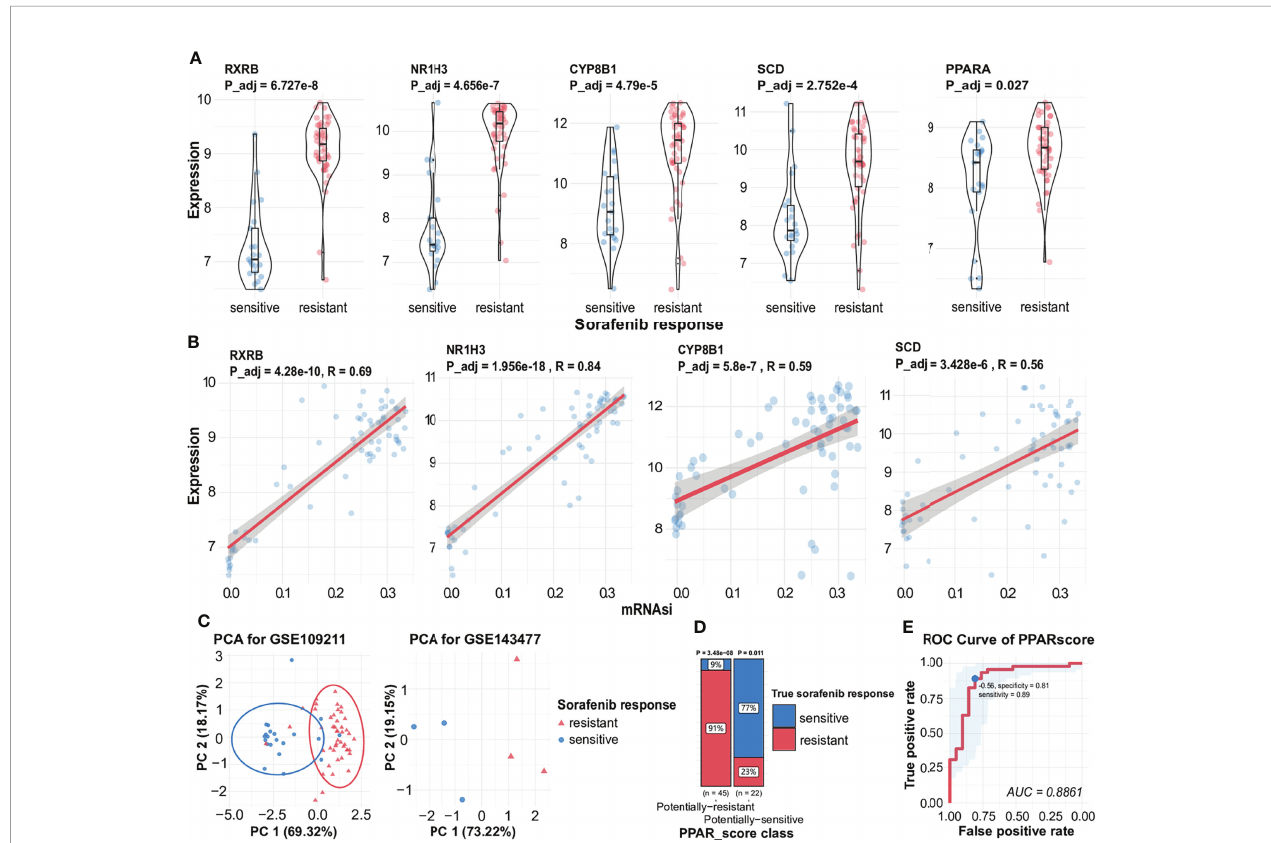
FIGURE 4 | Expression of key genes during the generation of different responses to sorafenib, the correlation between key genes and mRNAsi, and visualization of PPAR-related signature. (A) Expression of RXRB , NR1H3 , CYP8B1 SCD , and PPARA during different responses to sorafenib treatment with statistical signi fi cance. (B) Correlation analysis facilitated the identi fi cation of a signi fi cant positive association between mRNAsi and several sorafenib resistance genes ( RXRB , NR1H3 , CYP8B1 , SCD ). (C) AUC results are indicative of the expression of four genes in the sorafenib cohort GSE109211 (the left) and PCA results indicate the expression of four genes in the validated sorafenib cohort GSE143477 (the right). See also Figure S2 . (D) The proportion of different responses to sorafenib (responder or non- responder) in two groups of samples for four-gene scores. (E) ROC of PPARscore , the AUC value of PPARscore was 0.8861. The point with the highest speci fi city and sensitivity in the curve was